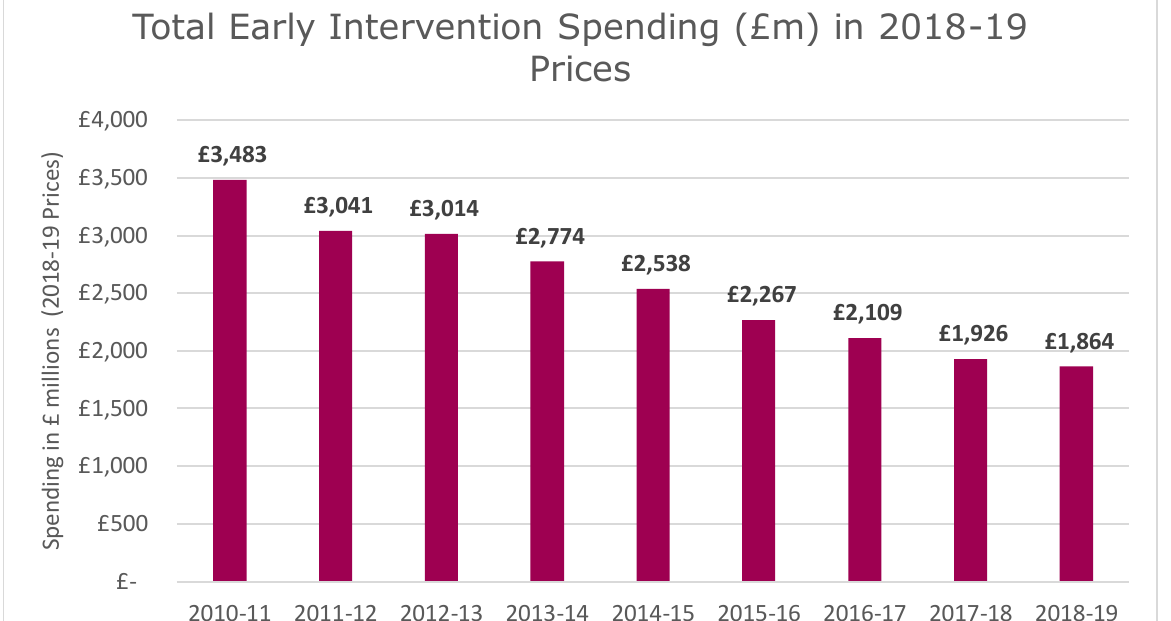
Table 5: Local authority spend on early intervention services in real terms 30